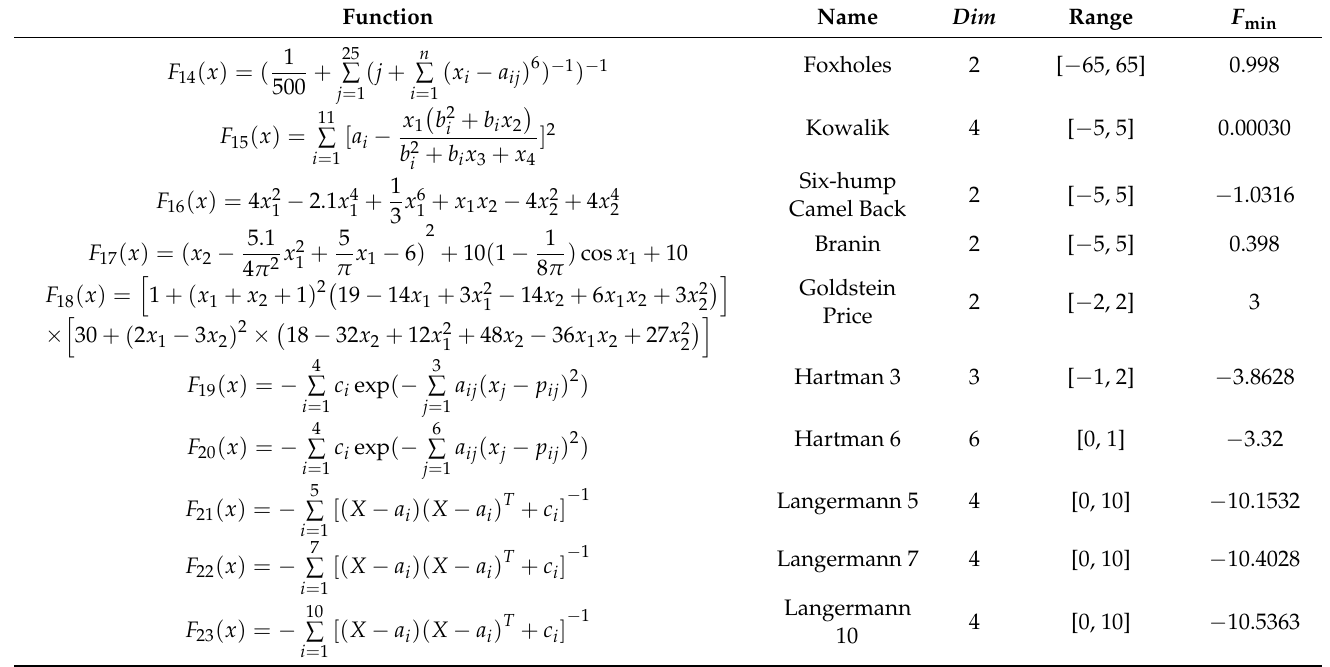
Table 3. Fix-dimension multimodal benchmark